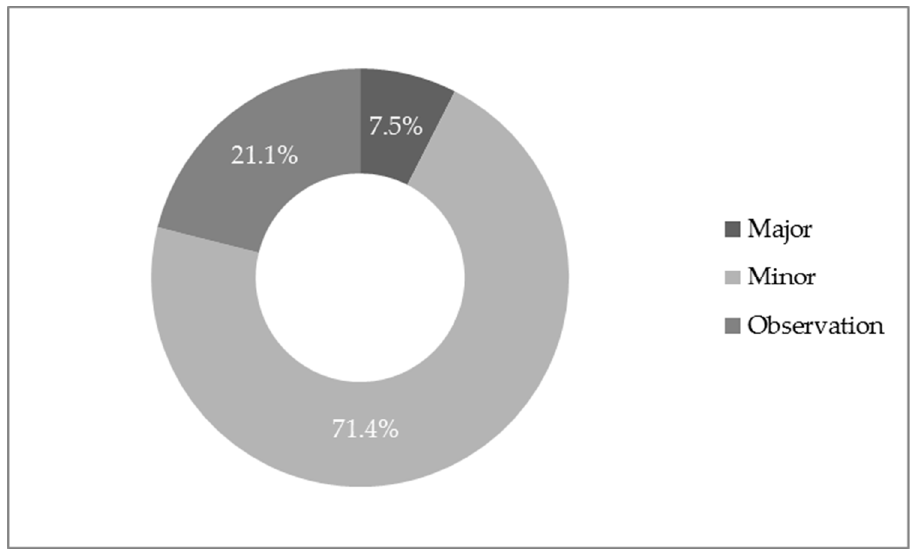
Figure 5. The number and distribution of non-conformities by severity.